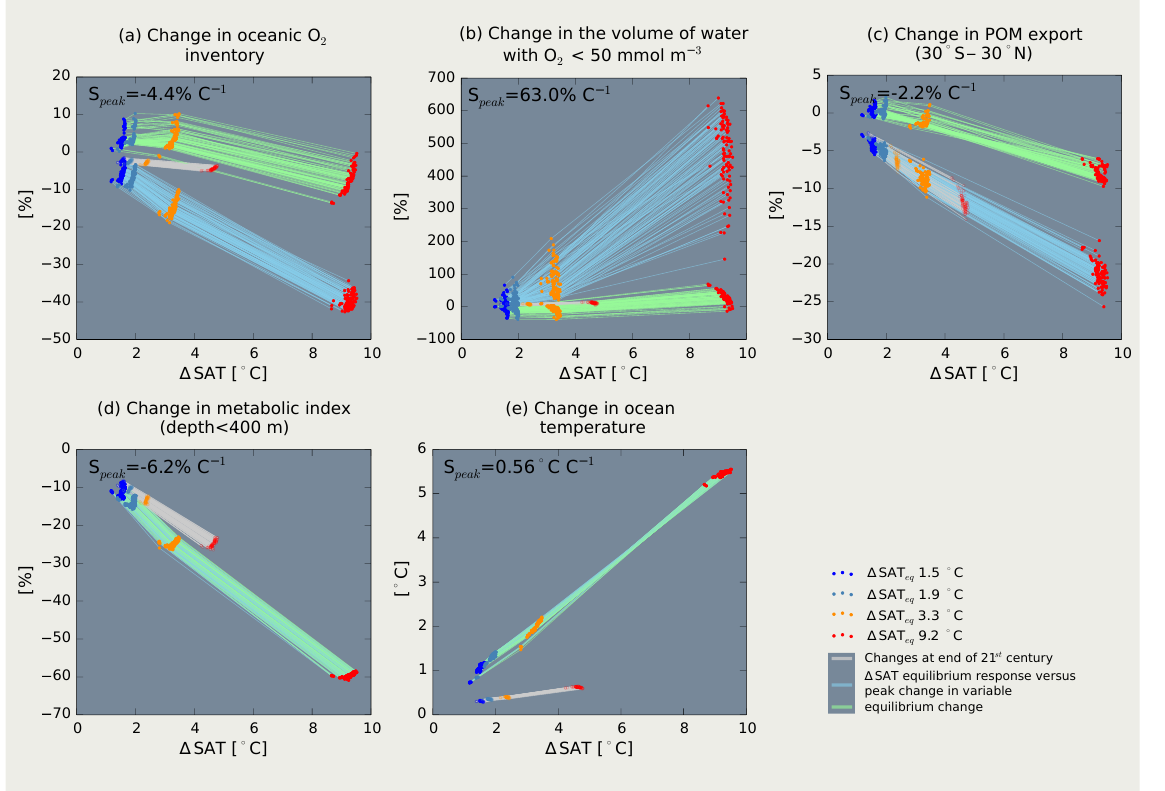
Figure 5. Changes in marine ecosystem stressors versus changes in global mean surface air temperature at three distinct points in time relative to 1870–1899. The colored dots indicate results of the four 100-member ensembles targeted to reach 1.5 (blue dots), 1.9 (light blue dots), 3.3 (orange dots) and 9.2 ◦ C (red dots) warming targets. The lines connect results of individual ensemble members at AD2100 (gray), at time of peak decline of each variable (light blue) and by the end of the simulation (light green) when a new equilibrium state has been reached. Peak and equilibrium changes in variables of interest are related to the corresponding equilibrium temperature response, while changes at the end of the 21st century are related to the transiently realized warming. Peak and equilibrium responses are indistinguishable in the figure for the metabolic index (d) and the ocean temperature change (e) . S peak is the peak sensitivity of each variable per ◦ C equilibrium